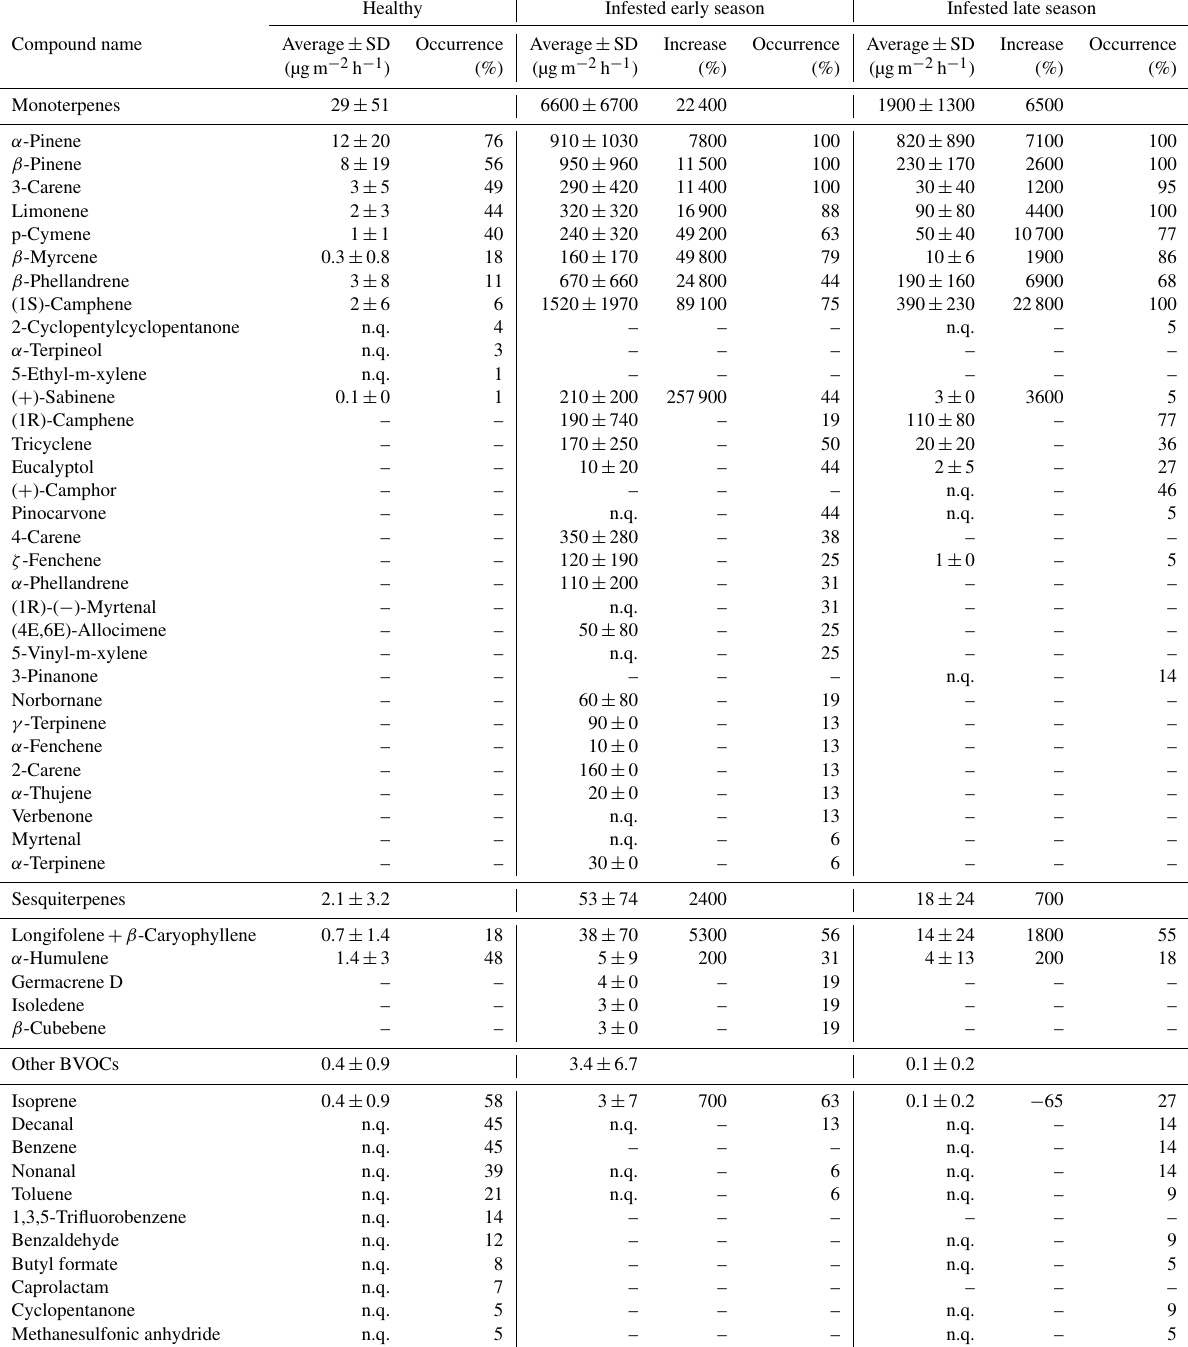
Table A1. Seasonal average temperature standardized emission rate (µgm − 2 h − 1 ± 1 standard deviation) from all Norway spruce trees located in Hyltemossa and Norunda. Presented are all the identified compounds, compound groups (monoterpenes, sesquiterpenes and other BVOCs), and total emission emitted from healthy and infested (early and late season) Norway spruce bark. The increase or decrease (%)